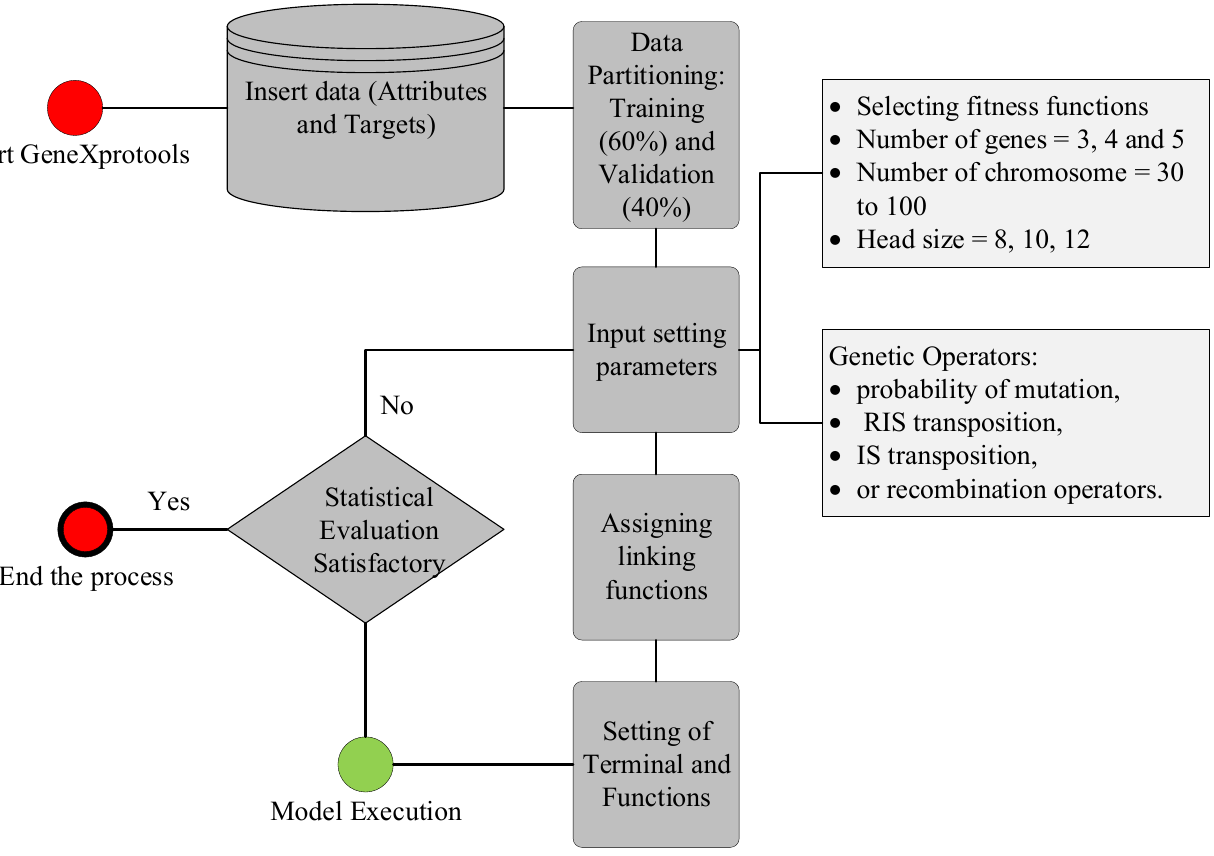
Figure 3. Operation of GEP modeling using GeneXprotools.